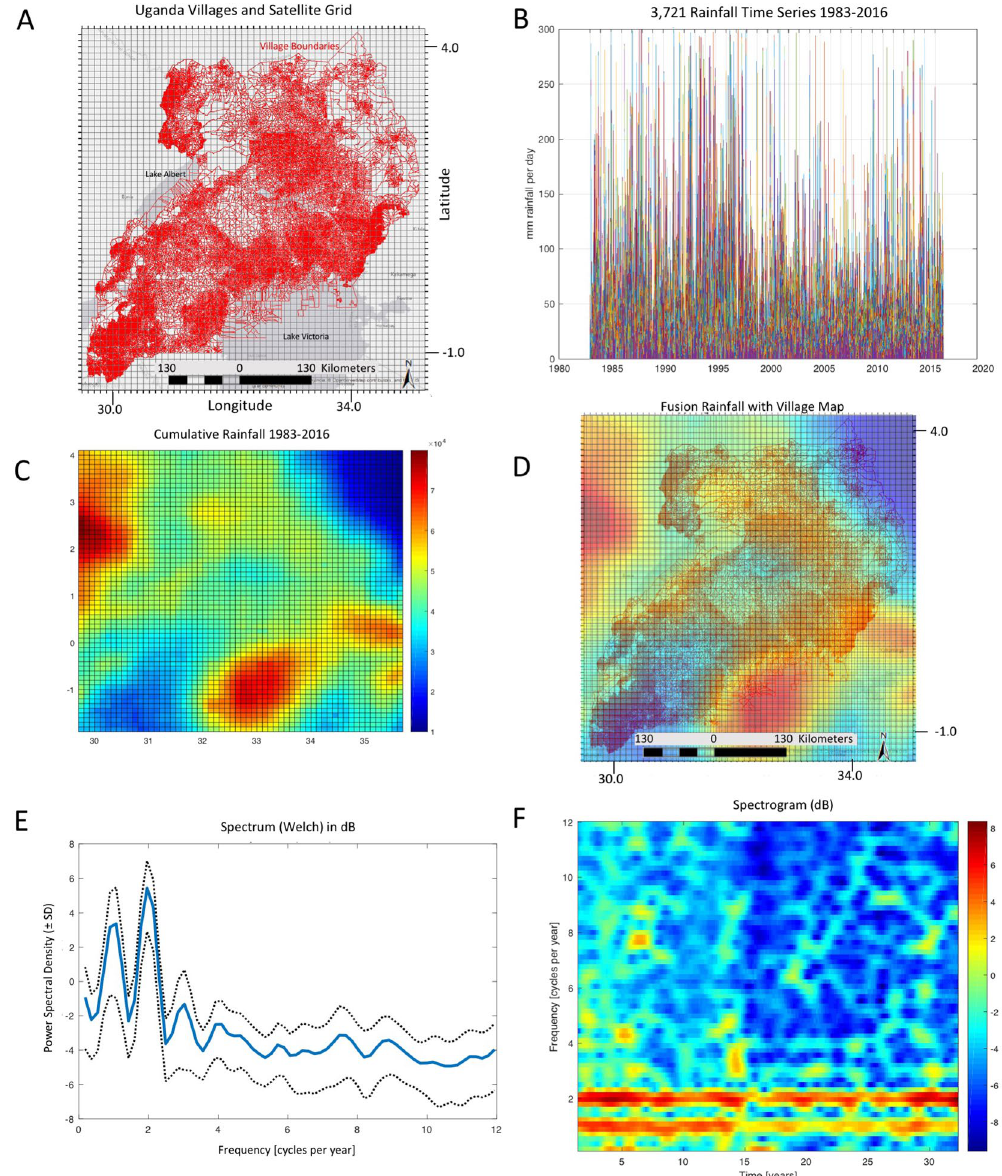
Figure 1. Fusion of satellite rainfall data with map of Uganda at the village level. Shown are the pattern of cumulative rainfall over the 34-year dataset, and the frequency content of the rainfall demonstrating twice- yearly rainy seasons. ( A ) Satellite grid overlay over Uganda showing the 44,034 villages as polygons, overlain with the 61 × 61, 0.1° × 0.1°, satellite grid (map created using ArcGIS 10.4.1, http://support.esri.com/Products/ Desktop/ArcGIS-desktop/arcmap/10-4-1). Darker grey regions represent water bodies (Lake Albert upper left, and Lake Victoria lower right). ( B ) Rainfall per day from each of 3,721 grid locations for 12,340 days. Abscissa labeled in years. ( C ) Cumulative rainfall (in mm in colorbar) on 61 × 61 grid for all 12,419 days over 34 years from 1983–2016. Map created using ArcGIS 10.4.1, http://support.esri.com/Products/Desktop/ ArcGIS-desktop/arcmap/10-4-1. ( D ) Fusion of cumulative rainfall with village and country map. Note that the heaviest rains are over the rainforest within the Congo River Basin to the west of Uganda, and where the northeast corner of Lake Victoria abuts the Ugandan land mass. The driest region is in northeast Uganda, where the Karamoja district abuts northwest Kenya and South Sudan. ( E ) Spectral density using Welch’s method in decibels (dB) estimated from each of 3,721 grid locations over 12,419 days, with mean and ± 1 SD. Hamming window of 3 × 365 with 95% overlap. Points plotted as decibels (10log10). ( F ) Spectrogram with mean removed from signal. Note the dominant rainy cycles at 1 × and 2 × per